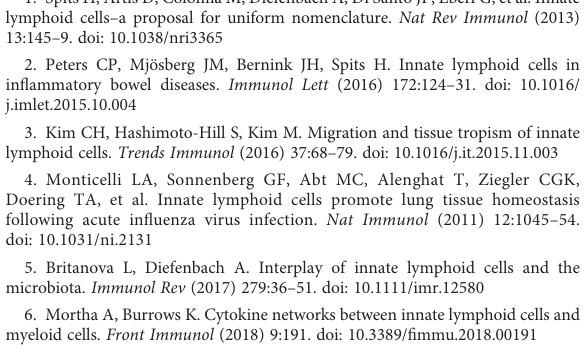
Summary tables of infection and activation/stimulation of ILCs by HAdVs or infected moDCs in the presence or absence of Nabs. (A) Infection capacity of ILCs by HAdVs. (B) Level of the CD69 marker by ILCs. (C) Secretion of cytokines by ILCs. (D) GFP and CD86 levels by DCs after HAdVs challenge. (E) CD69 level by ILCs after indirect challenge by moDCs. (F) Secretion of cytokines by ILC after indirect challenge by moDCs. Only cytokines with a secretion level at least 2-fold higher than controls were shown. IC for Ig – HAdVs